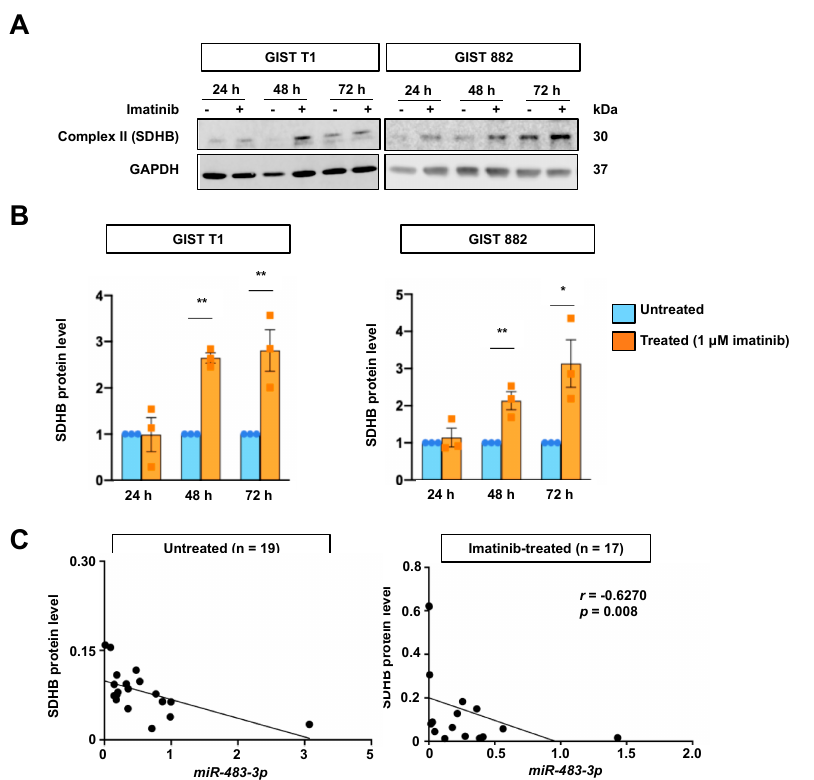
Figure 4. Relationship between succinate dehydrogenase B (SDHB) protein expression and imatinib treatment or miR-483-3p . ( A ) Representative Western blots showing SDHB protein expression in GIST cell lines with and without imatinib treatment (1 μ M). GAPDH was used as a loading control. ( B ) Quantification of SDHB expression upon imatinib treatment of GIST cell lines at different time points. Differences between groups were calculated using paired t-test. * p < 0.05, ** p < 0.01 ( n = 3). ( C ) Inverse correlation between SDHB protein expression and miR-483-3p in untreated and imatinib-treated GIST tumor samples.